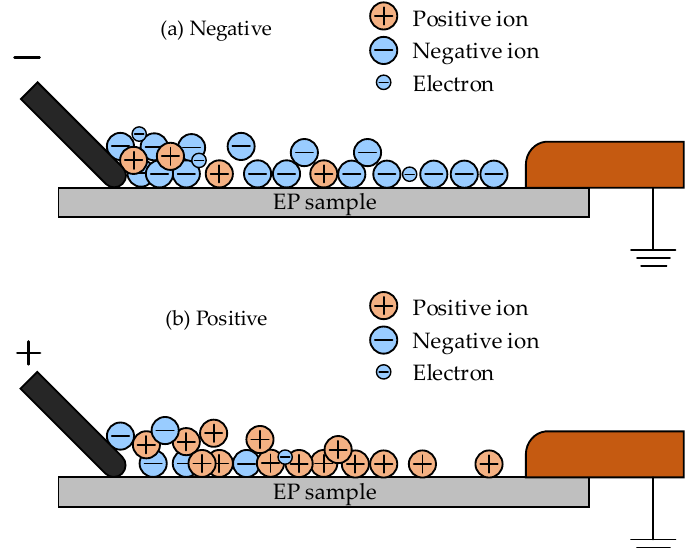
Figure 15. Charge characteristics on the surface at a high pressure with different polarities.